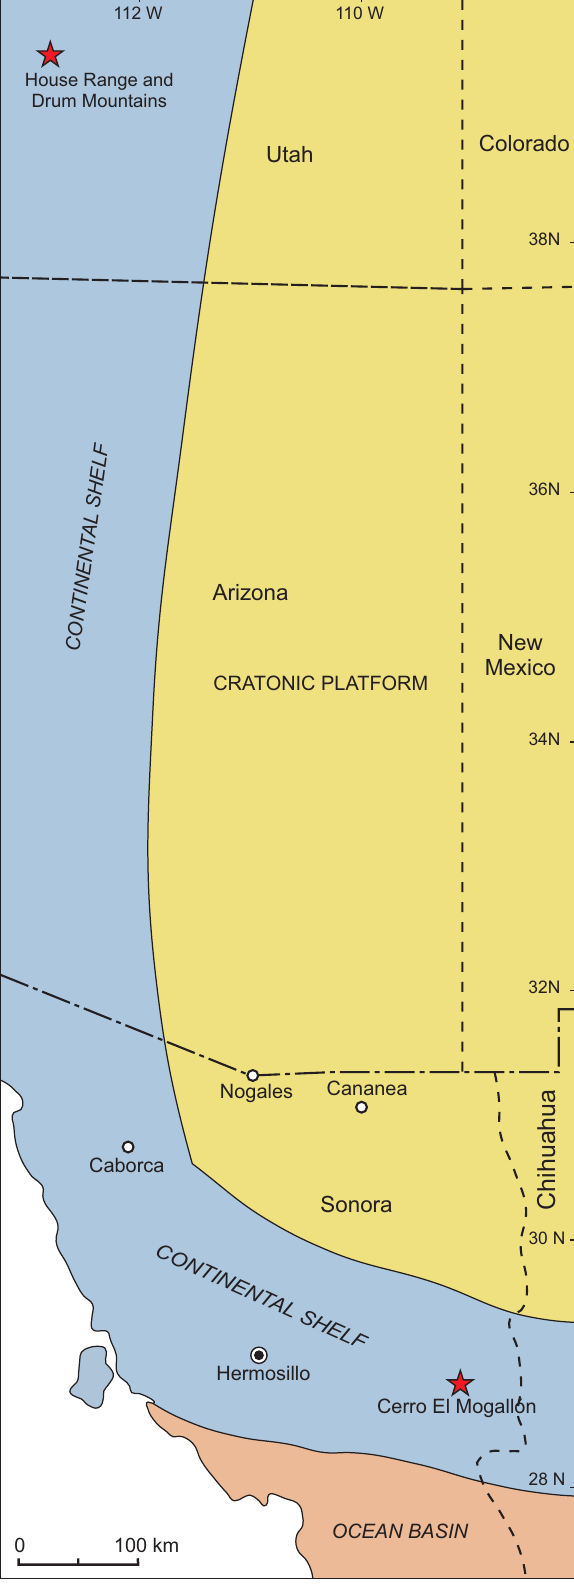
Fig. 7. Generalized map of southern part of Laurentia showing the distri- bution of Cambrian platform, shelf basin deposits, and the location of the Cerro El Mogallón, at Arivechi, Sonora (after Page et al.